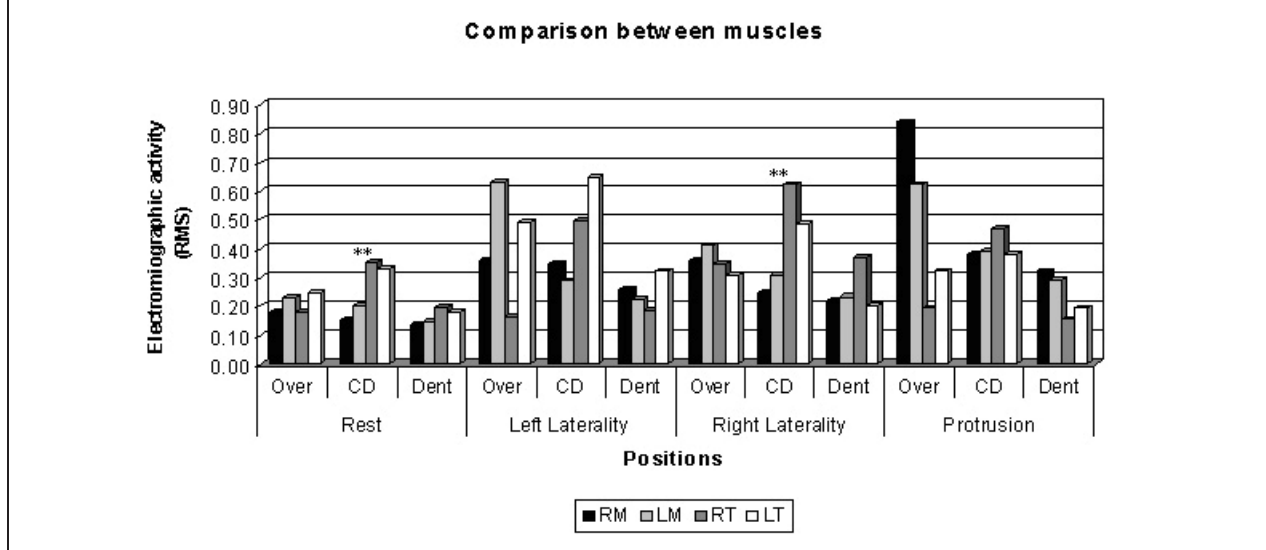
Fig. 2 - Normalized electromyographic averages (RMS) of right masseter (RM) and left masseter muscles (LM), and right (RT) and left (LT) temporalis in the groups: overdenture wearers (Over), complete denture wearers (CD), and dentate individuals (Dent); Recordings at rest, left laterality, right laterality and protrusion. ** Statistically significant if